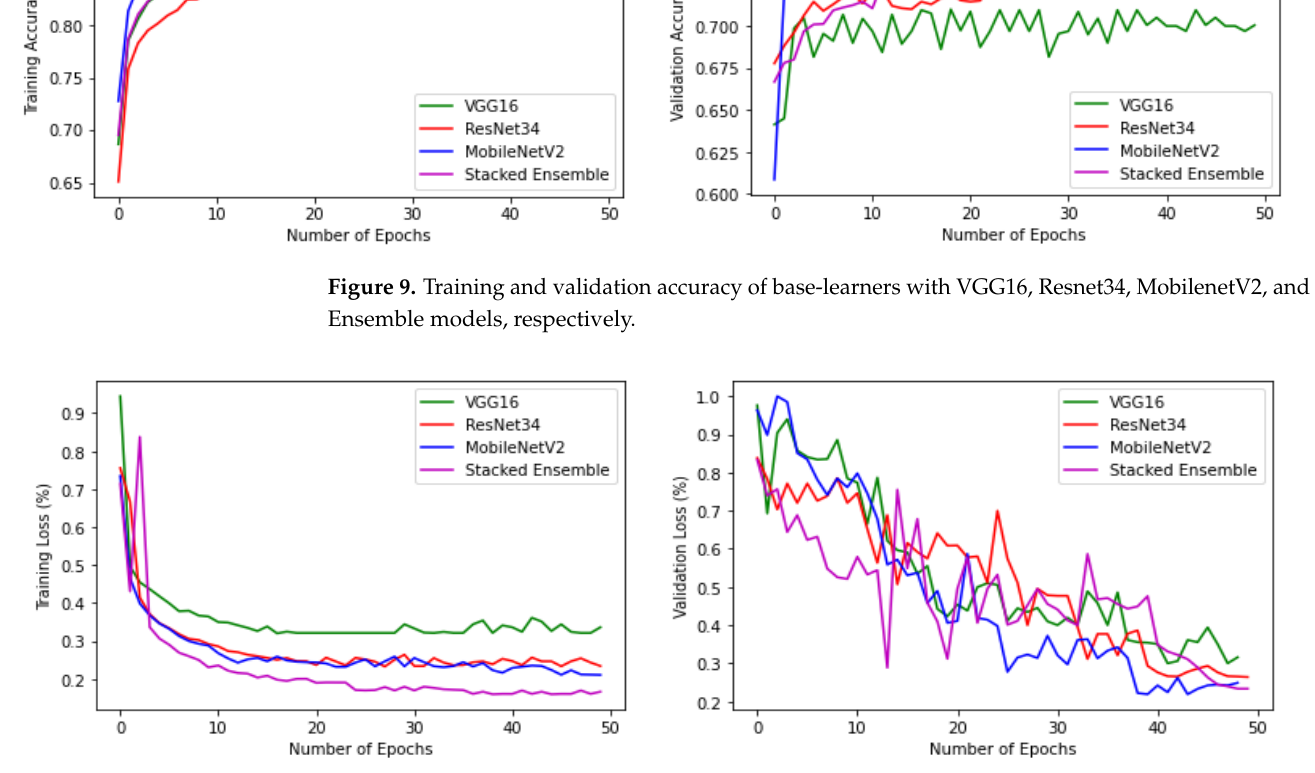
Figure 10. Training and validation loss of base-learners with VGG16, Resnet34, MobilenetV2, and Ensemble models, respectively.